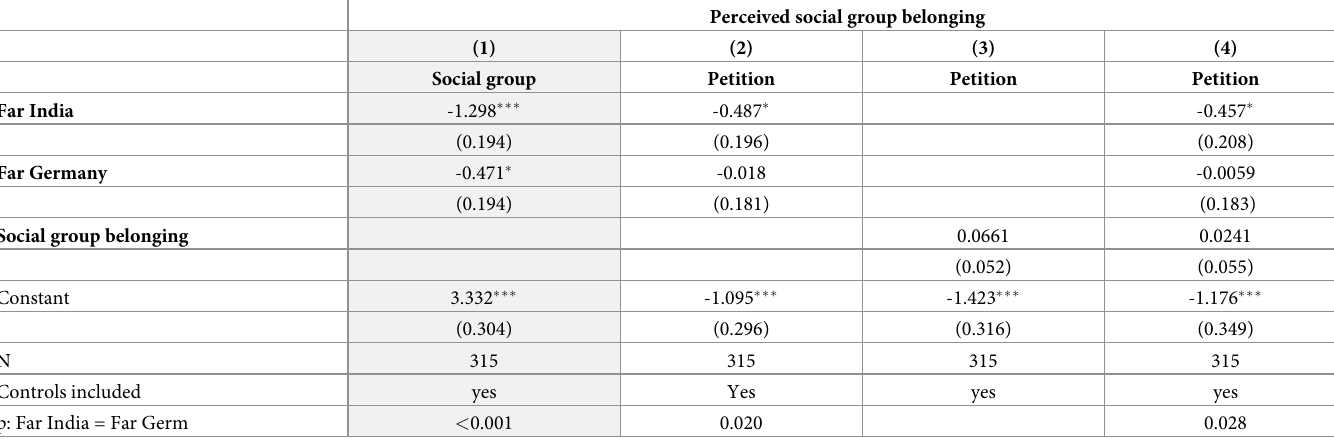
Table 2. Regression results for social group belonging as possible mediation